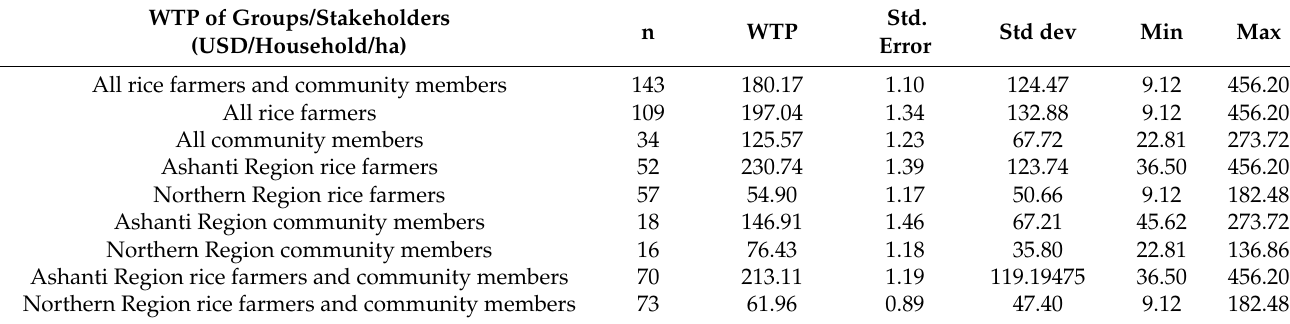
Table 3. Rice farmers’ and community members’ WTP (weighted means).